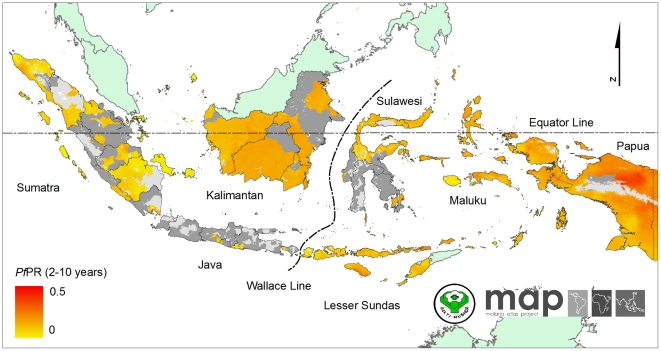
The Plasmodium falciparum malaria PfPR2–10 endemicity map.Model-based geostatistical point estimates of the annual mean PfPR2–10 for 2010 within the stable spatial limits of P. falciparum malaria transmission, displayed as a continuum of yellow to red from 0%–50% (see map legend). The rest of the land area was defined as unstable risk (medium grey areas, where PfAPI<0.1 per 1,000 pa) or no risk (light grey, where PfAPI = 0 per 1,000 pa).